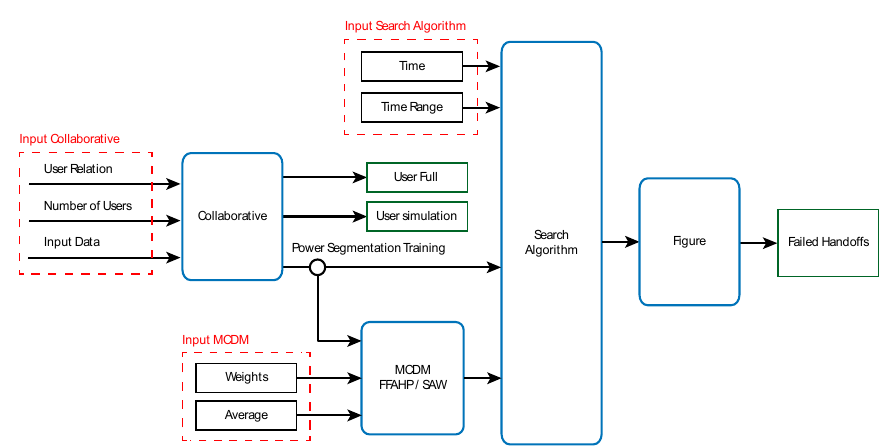
Figure 14. Block diagram of the collaborative model, multi-criteria, and search algorithm.